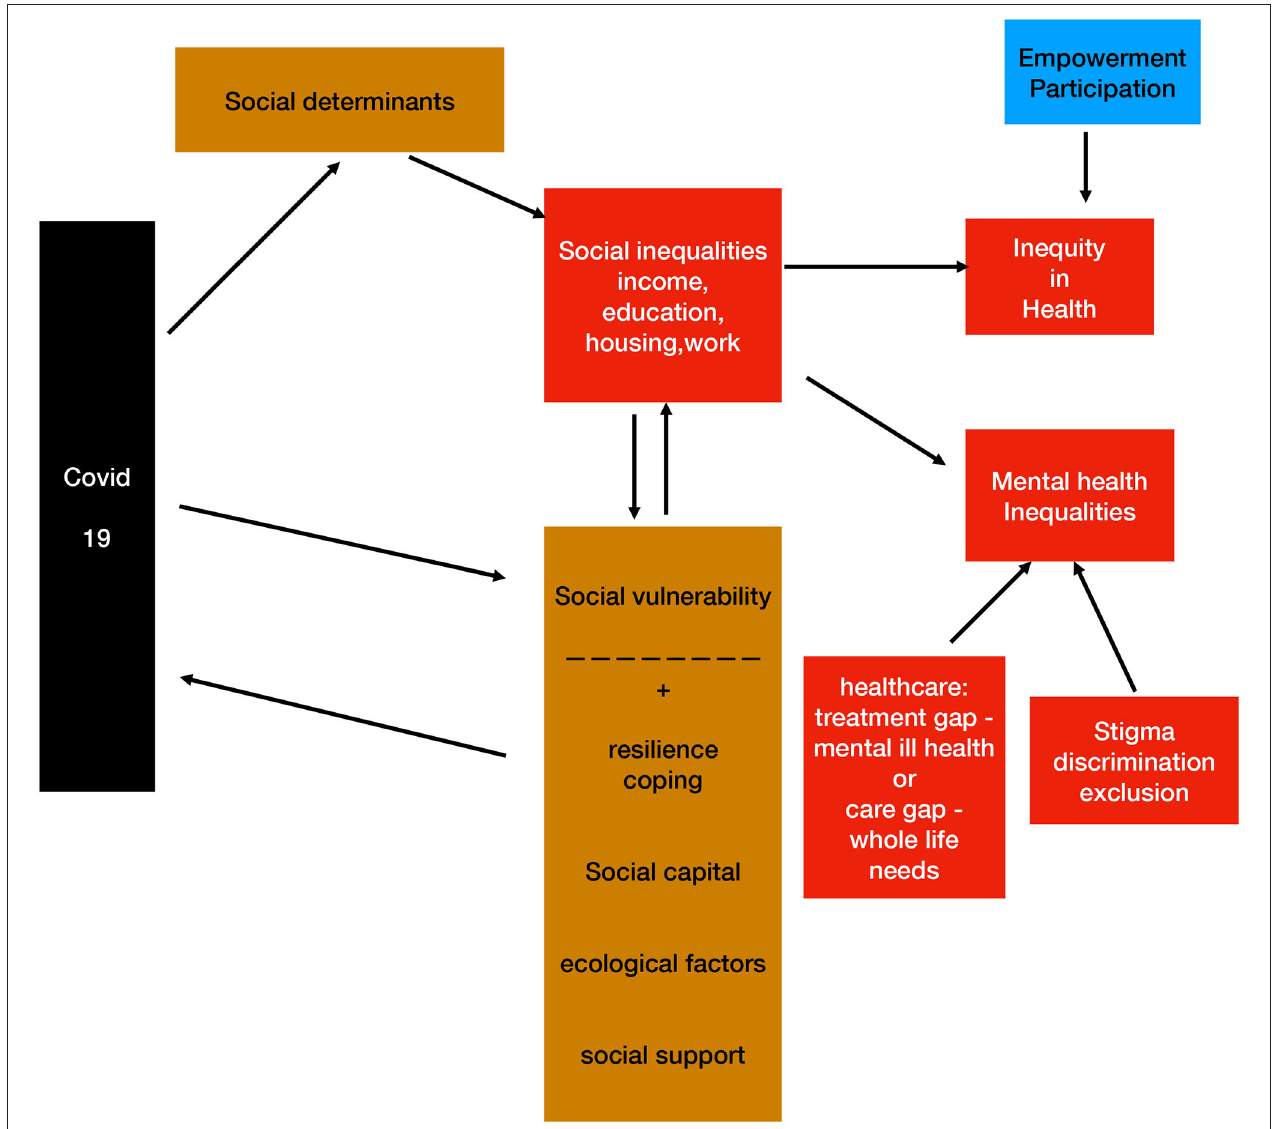
FIGURE 1 | A map of interacting domains and